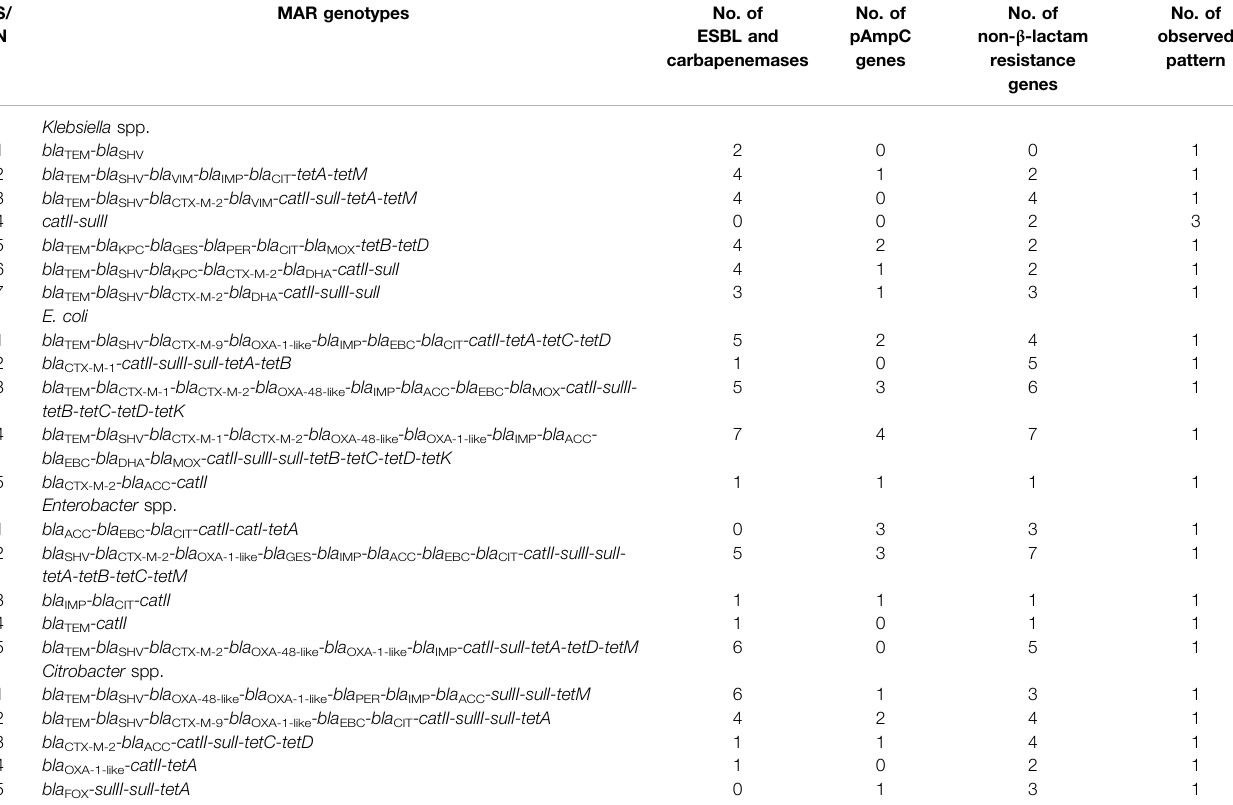
TABLE 2 | The patterns of the various multiple antibiotic resistance genotypes of Enterobacteriaceae recovered from wastewater treatment plants ef fl uents. S/